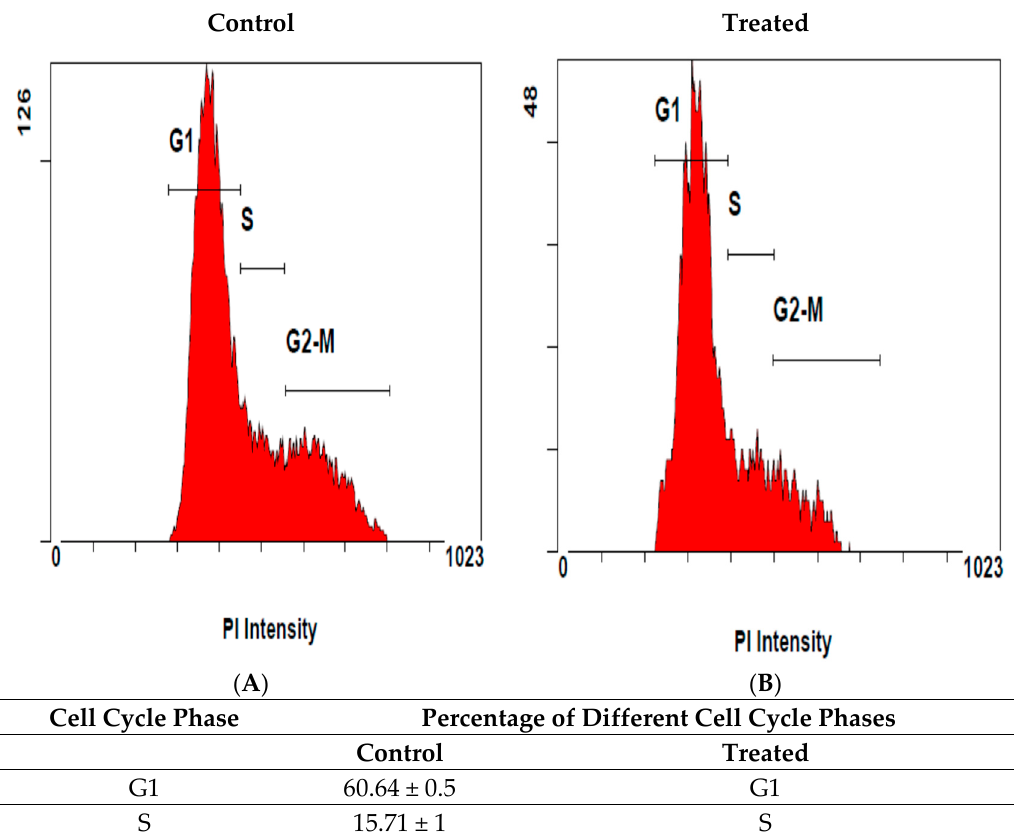
Figure 3. Cell cycle distribution profiles for the effects of the methanol extract of shoots of M. sinaica on MDA-MB-231. Cells were incubated for 24 h ( A ) without (control) and ( B ) with the methanol extract of shoots of M. sinaica and stained with PI. Following Fluorescence Activated Cell Sorting (FACS) analysis, DNA histograms were analyzed using CXP software V. 3.0. Data represent mean ± S.D. and the difference was statistically significant at (* P < 0.05) compared to control.